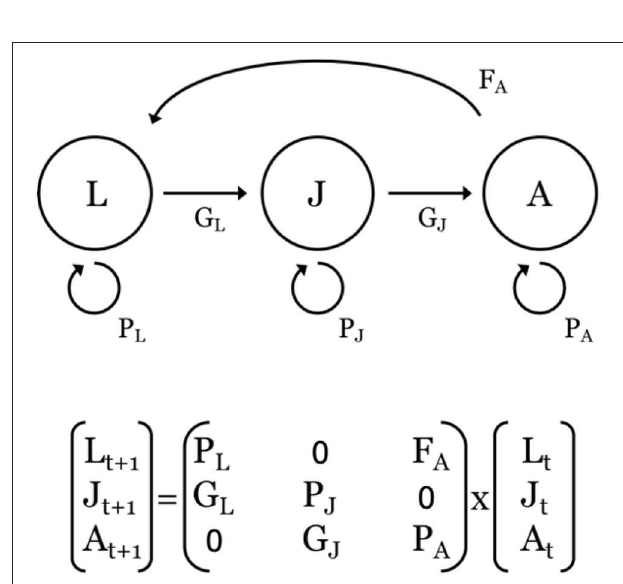
FIGURE 4 | Top : Representative stage-based, life-cycle diagram and associated transitions ( F , G , P ) of a population defined by three stages: larvae ( L ); juveniles ( J ), and adults ( A ). F = fecundity, defined as the number of offspring, P = probability of survival and remaining within a stage, and G = probability of survival and growing into the next stage. Bottom : Corresponding projection matrix and population vectors at times t and t + 1 for the population described above. The time step is usually one year. For species that make ontogenetic migrations across larval, juvenile, and adult life-history stages, the G parameters are often associated with a switch in habitat